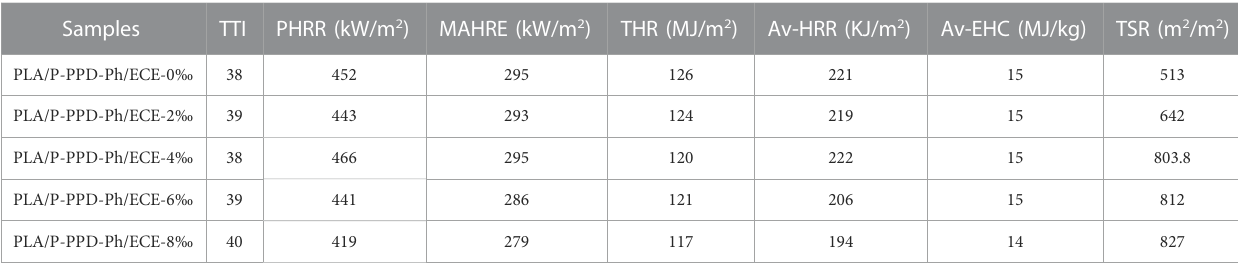
TABLE 3 Cone calorimeter test data for PLA/P-PPD-Ph/ECE conjugated fl ame retardant